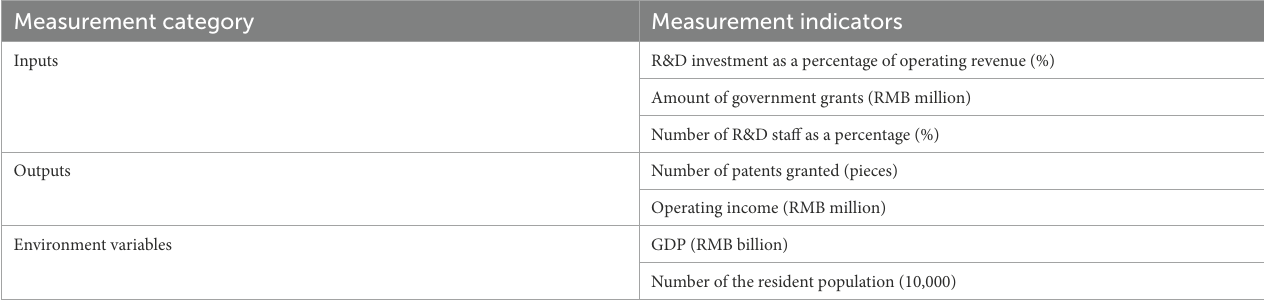
TABLE 1 Input–output indicators for the integration of technology and finance in strategic emerging enterprises. Measurement